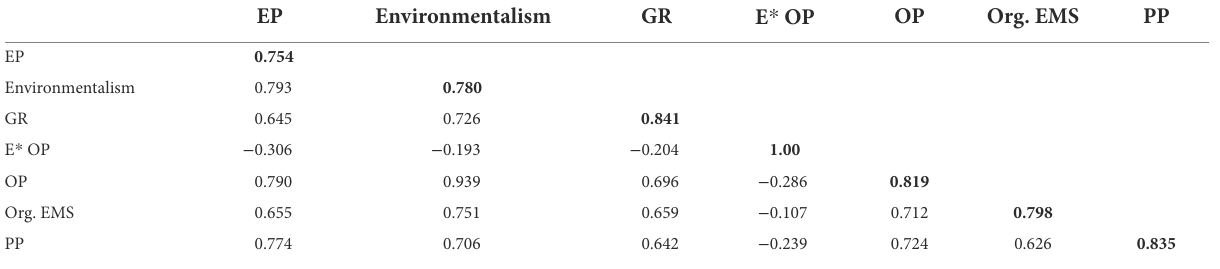
TABLE 4 Discriminant validity at construct level.